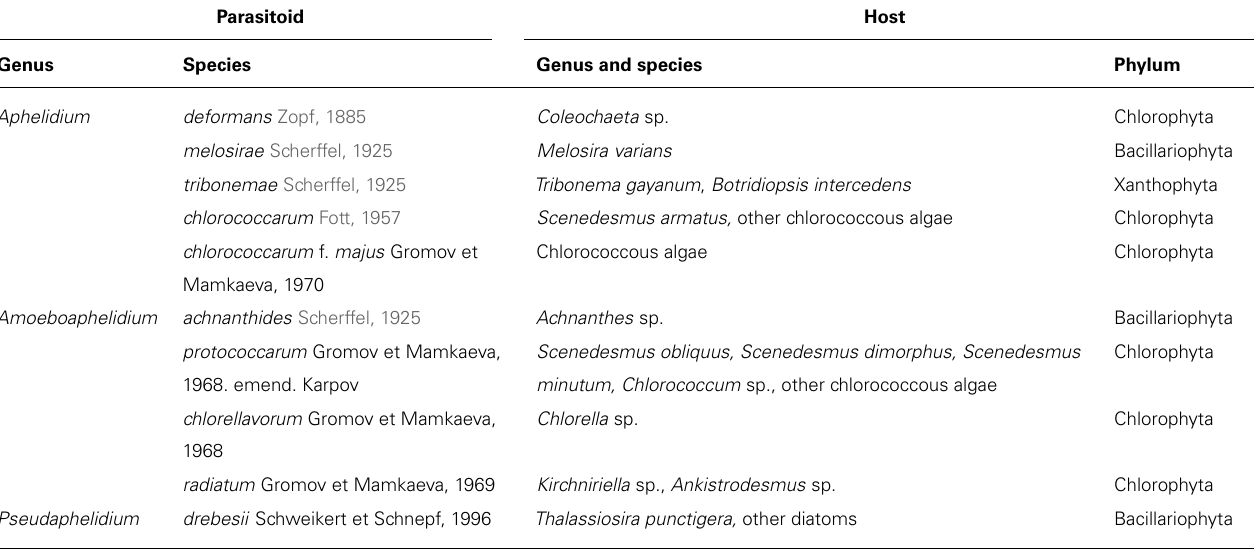
Table 1 | Species of aphelids and their